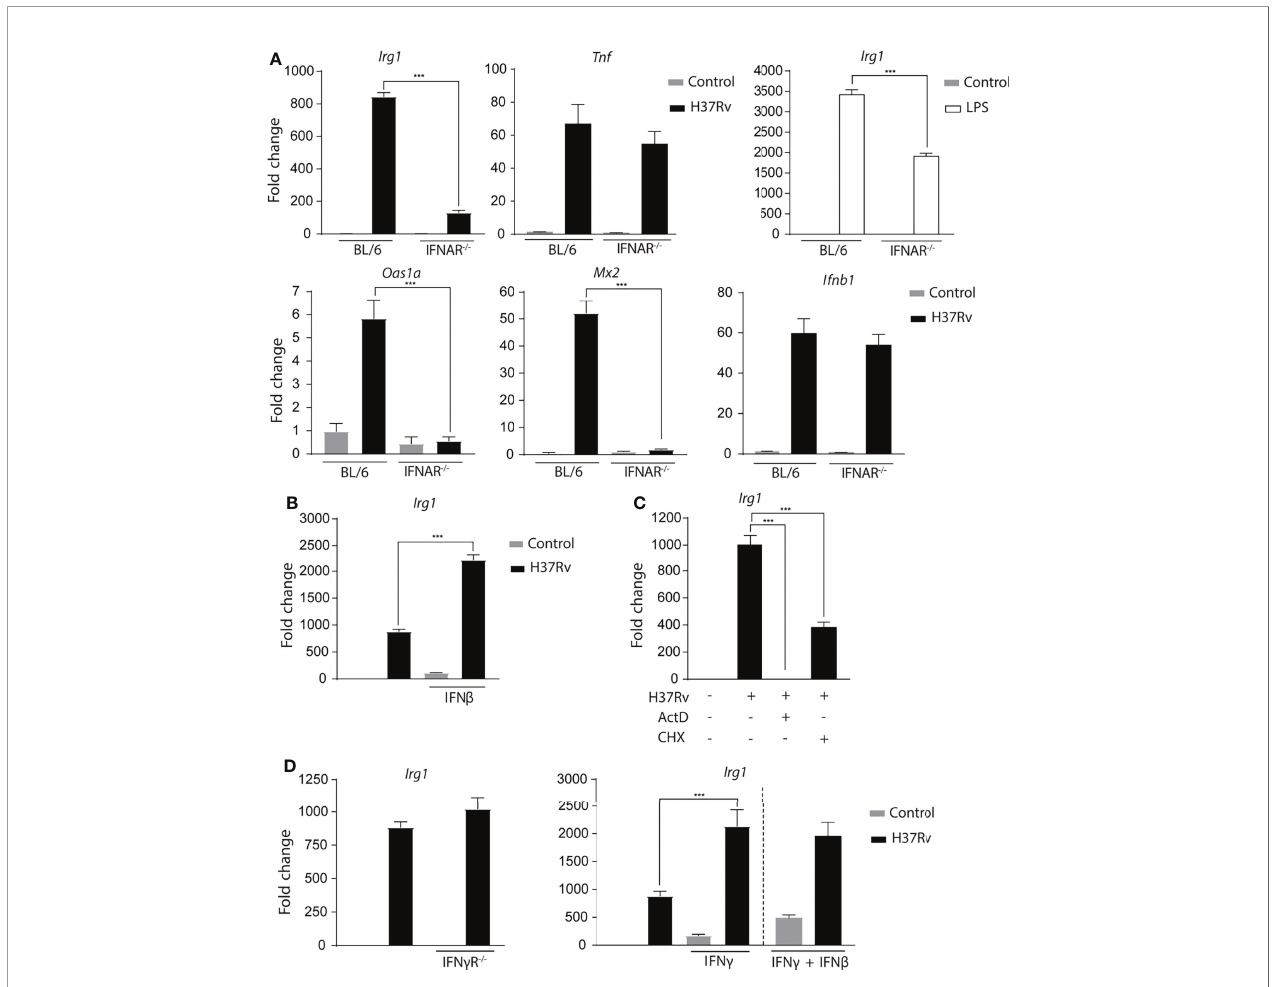
FIGURE 5 | Mtb -induced Type I interferon signaling plays a major role in Irg1 expression. (A) mRNA levels of Irg1 , Tnf , Ifnb1 , Oas1a and Mx2 were measured in IFNAR -/- and C57BL/6 BMDMs at 6 h following H37Rv Mtb infection or LPS stimulation (10 ng/ml). (B) Irg1 mRNA expression was assessed in C57BL/6 BMDMs treated or not with recombinant IFN- b (10 ng/ml). (C) mRNA levels of Irg1 were evaluated in C57BL/6 BMDMs pretreated with actinomycin D (ActD) (1 µg/ml) or cycloheximide (CHX) (10 µg/ml) for 2 h and then infected with H37Rv Mtb for 6 h. (D) Irg1 mRNA expression was assessed in Mtb-infected IFN g R -/- and C57BL/6 macrophage cultures in the presence of recombinant IFN g (10U/ml) and/or IFN b (10 ng/ml) at 6 h p.i. Signi fi cant differences are indicated with asterisks (***p < 0.001). The data shown are representative of two separate experiments